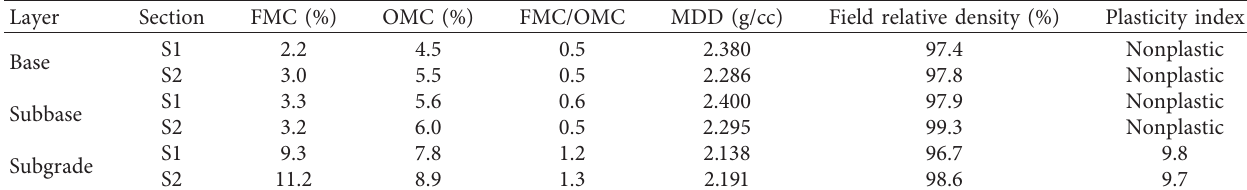
Table 5: Results from test pit materials.